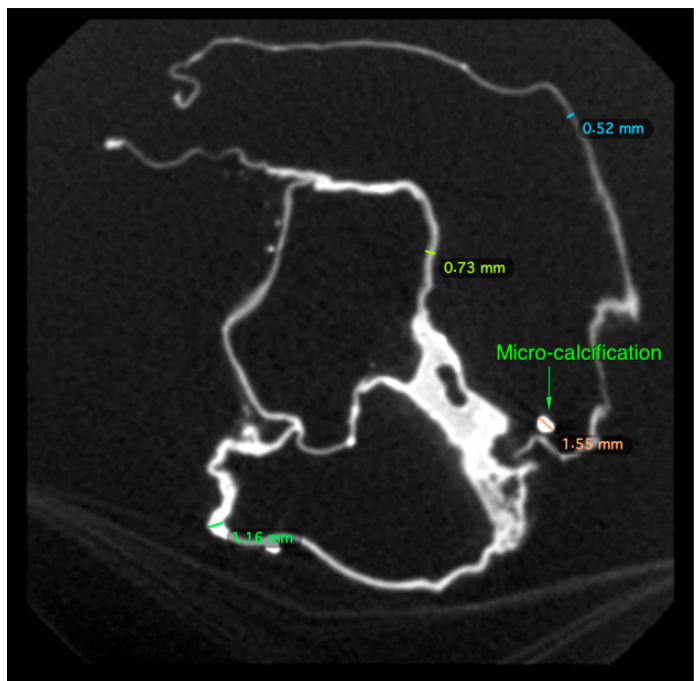
Figure 5. Parietal micro-calcification and measurement of the external/inter-cavitary walls of the heart of P. Jaricot .